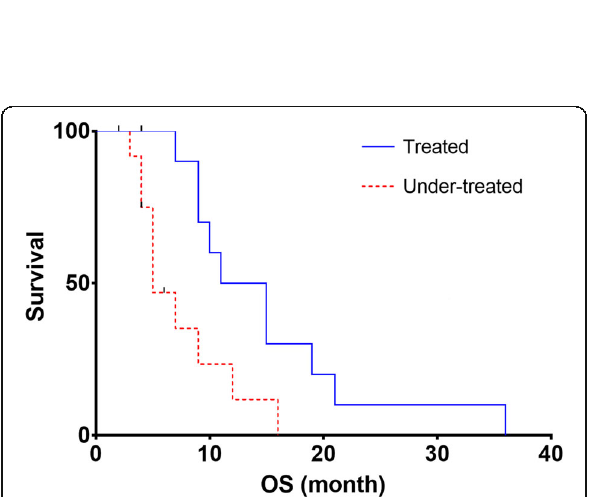
Fig. 5 OS curves estimated by the Kaplan-Meier method according to the treated group (all the lesions received a mean absorbed dose superior to 39 Gy) versus the under-treated group (at least one lesion received a mean absorbed dose inferior to 39